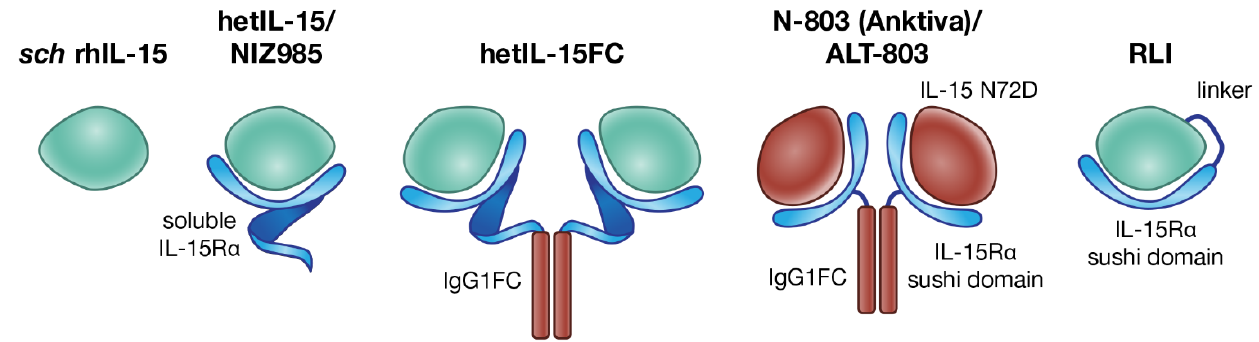
Figure 2. Different IL-15 preparations used in cancer immunotherapy. The single-chain E. coli -derived IL-15 ( sch rhIL-15, left) [53] is the first IL-15 tested in the clinic, but its use is limited by the short half-life and potential toxicity. The natural form of IL-15 produced physiologically is the heterodimer of IL-15 with IL-15R α . Several heterodimeric forms have been developed. From left to right, human embryonic kidney 293 (HEK293)-derived or Chinese hamster ovary (CHO)-derived hetIL-15/NIZ985, the soluble heterodimer of IL-15 with IL-15R α , upon natural shedding of IL-15R α from the membrane of producing cells [54]; human HEK293-derived hetIL-15FC, a dimeric form in which soluble IL-15R α is fused to the Fc region of IgG1; N-803, also known as Anktiva and ALT-803, consisting of a CHO-derived soluble complex comprising mutated IL-15 (IL-15 N72D) and a dimeric IL-15R α sushi domain-IgG1 Fc fusion protein [55]; Receptor-Linker-IL-15 (RLI) consists of the IL-15R α sushi domain fused to IL-15, via a 20-amino acid flexible linker [56].